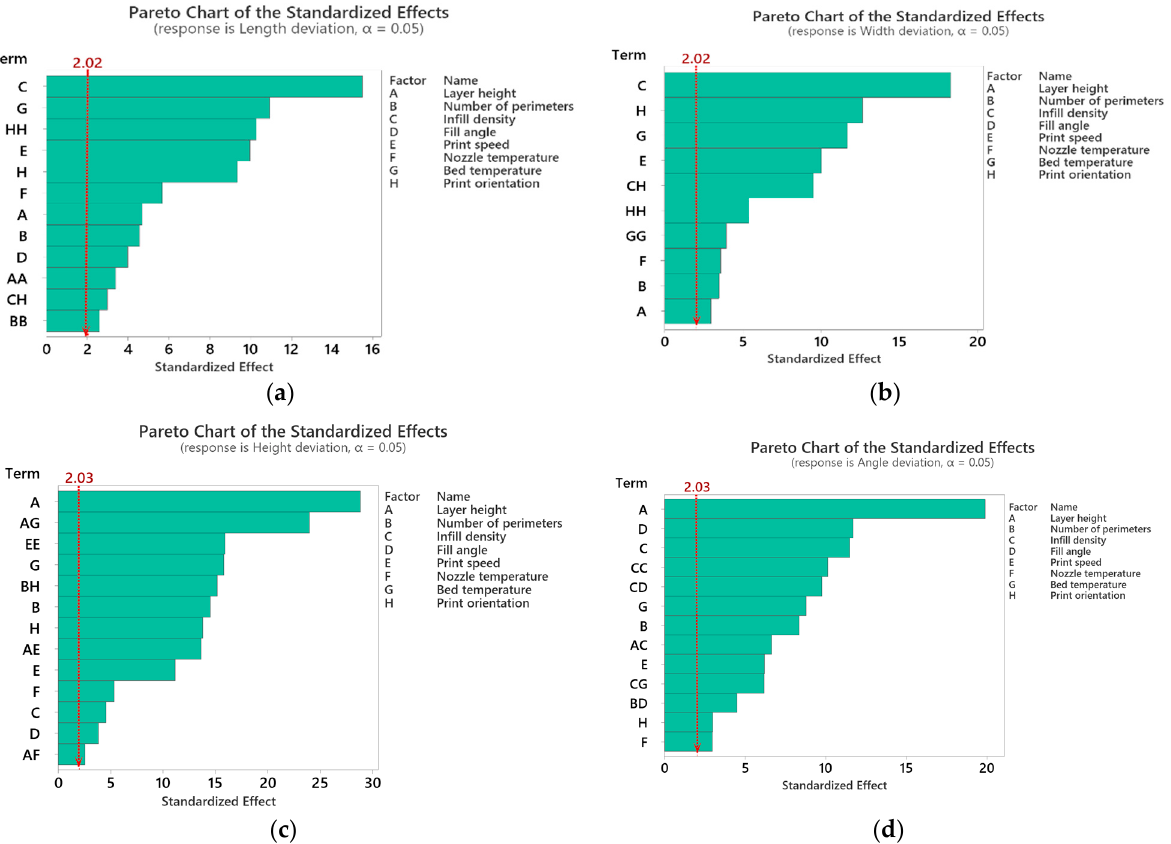
Figure 5. Pareto chart of standardized effect of dimensional deviation ( a ) length deviation, ( b ) width deviation, ( c ) height deviation, ( d ) angle deviation.